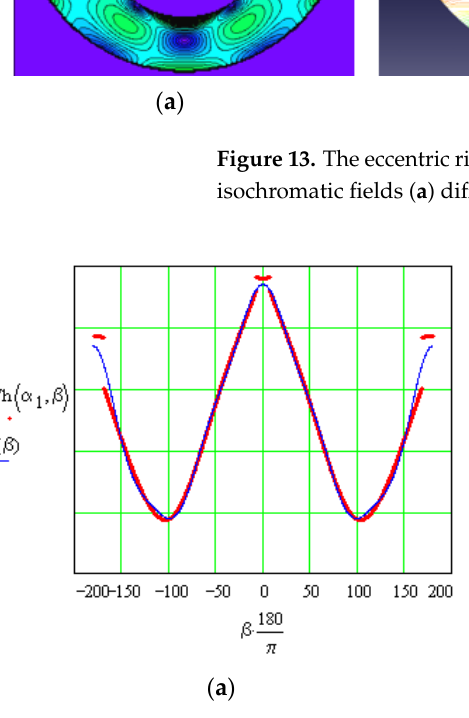
Figure 14. Variation of the potential and its derivative: ( a ) variation of the potential Wh ( α , β ) and of the attached trigonometric polynomial T ( β ) on the inner boundary of the ring α = α 1 ; ( b ) variation of the derivative of the potential ∂ Wh ( α , β ) / ∂α and of the derivative of the attached trigonometric polynomial T α ( β ) on the inner boundary of the ring α = α 1